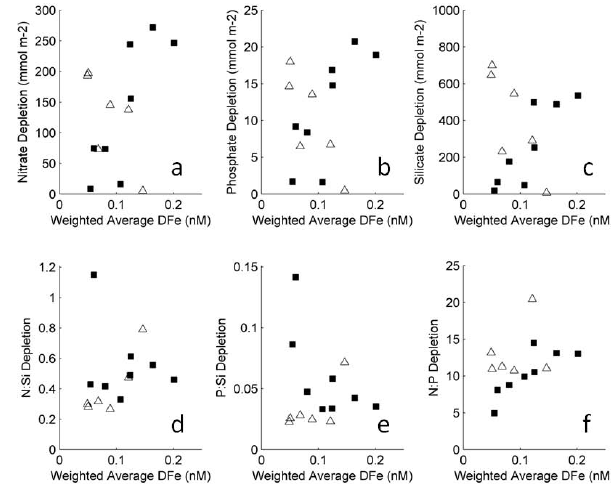
Fig. 7. Removal of nitrate (a) , silicate (b) , phosphate (c) and the re- moval ratios of N:Si (d) , P:Si (e) and N:P (f) vs the weighted av- erage DFe concentrations for the Weddell Sea transect (open trian- gles), and the Greenwich Meridian transect (filled squares) (Klun- der et al.,